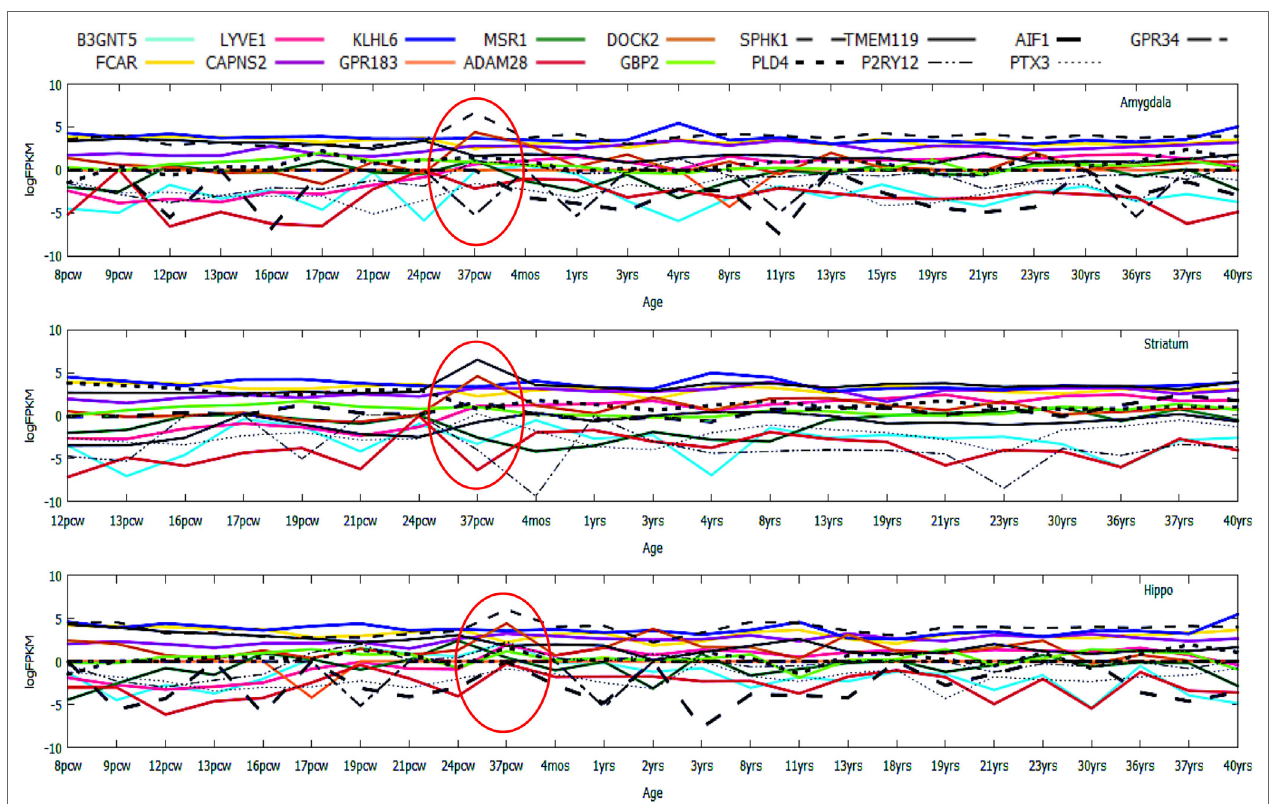
FigUre 6 | Age-wise expression dynamics of highly upregulated genes across microglia-enriched regions of the human brain. Gene expression profiling of top 10 upregulated genes and known expressed biomarkers (17) in the developing/degenerating brain including prenatal stages like 9 pcw fetus and postnatal brain stages like 3 years to a grown adult 40-year-old